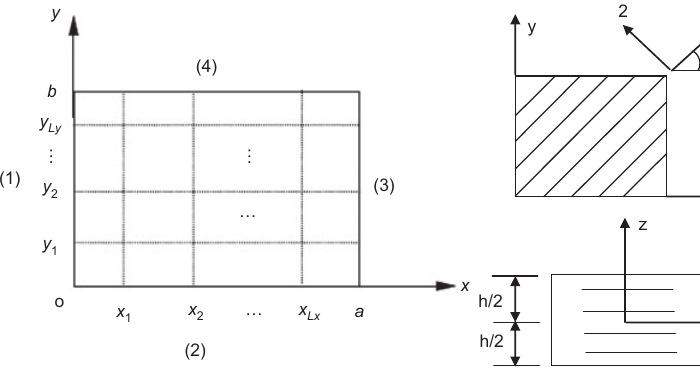
Figure 1 Geometry of a rectangular laminated plate with internal line